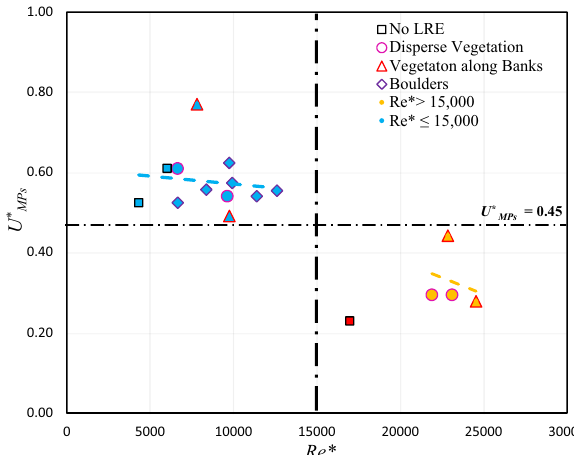
Figure 2. The relationship between shear Reynolds number (Re*) and dimensionless microplastics velocity ( U ∗ MPs ). (The red data point is for no LREs scenario and is not considered in the analysis).